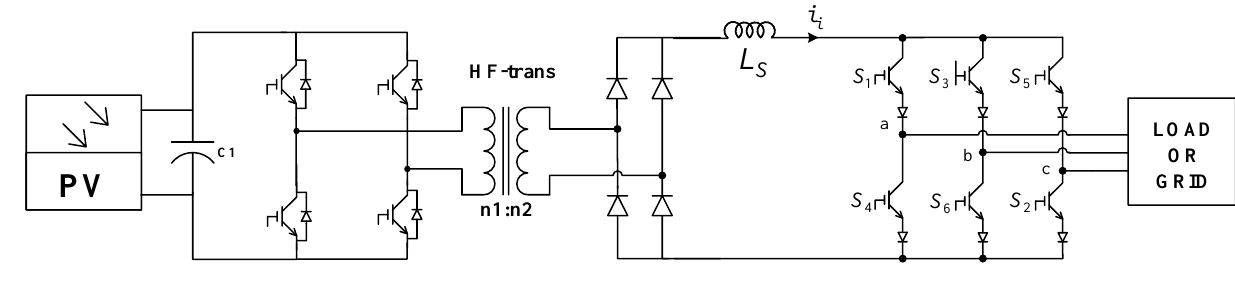
Figure 4. PV system with a high-frequency (HF) transformer.